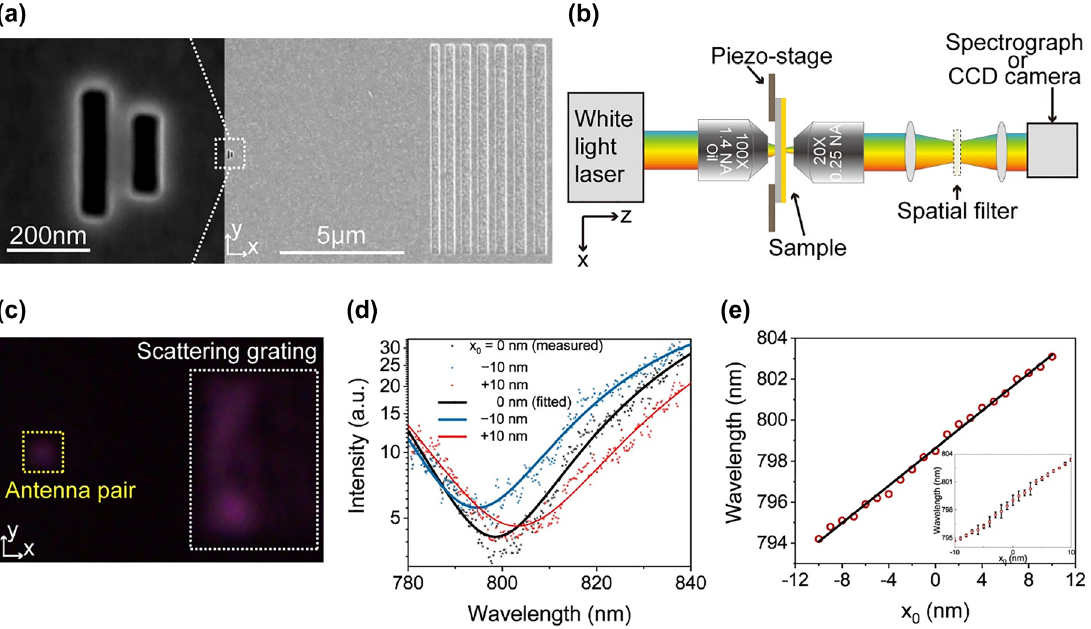
Figure 3: Experimental results of the sensor. (a) SEM image of fabricated slot antennas and scattering grating. Inset: Magnified SEM image of the antenna pair. (b) Schematic of the experimental setup. (c) CCD image of the antenna pair and diffraction grating under the illumination of an x -polarized supercontinuum light laser. (d) Output spectra (dots) and the corresponding polynomial fi ttings (lines) for different x 0 values. (e) Extinction wavelength versus the displacement. The line presents the linear fi tting. Inset: Extinction wavelength and measurement uncertainty versus the